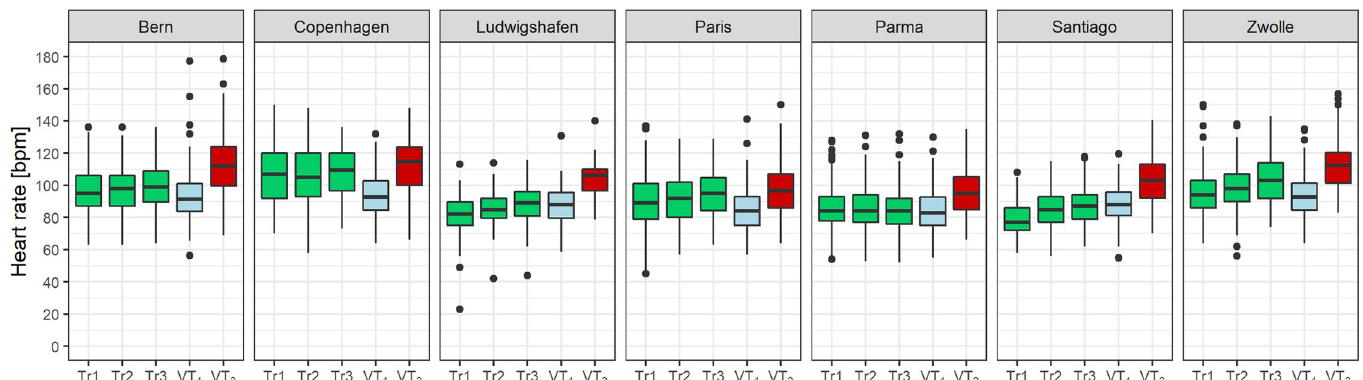
Fig 2. Training heart rate (green) at beginning (Tr1), middle (Tr2) and end (Tr3) of CR compared to heart rate at first and second ventilatory threshold (VT 1 , VT 2 ) at CR start for each centre.